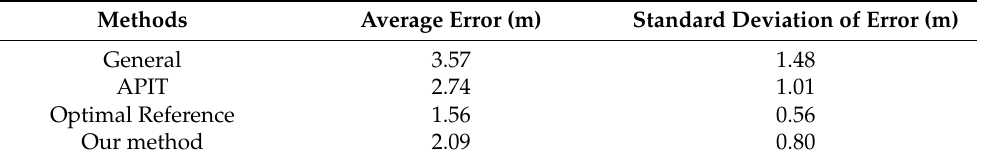
Figure 12. The cumulative distribution function of the positioning error. The jump in the position of the black frame is caused by the test results of T1 and T9. Table 5. Statistical result of different